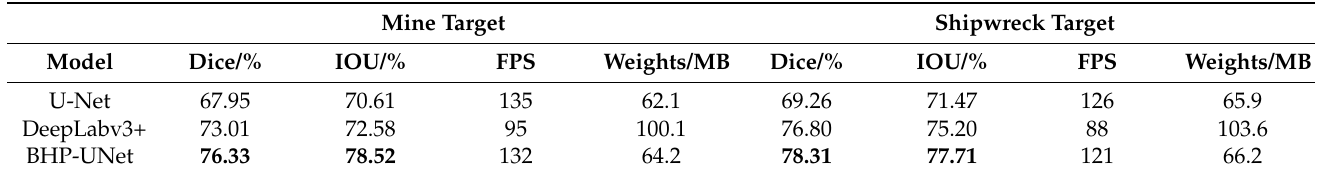
Table 9. Comparison of segmentation performances of the BHP-UNet model and conventional models.